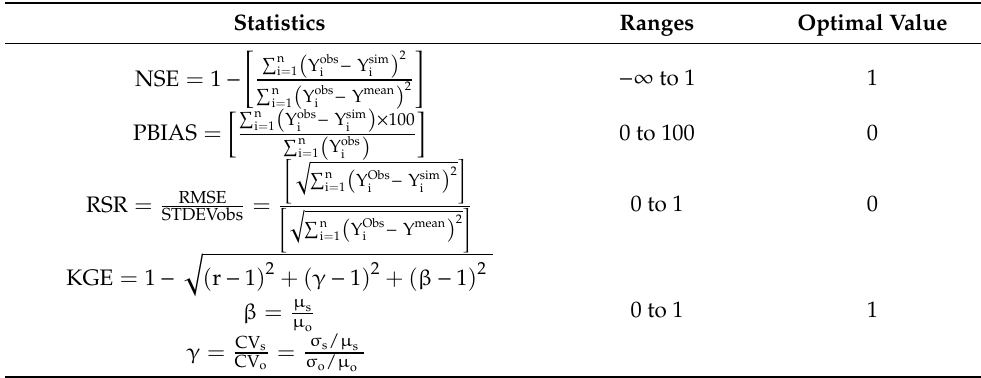
Table 1. Representing statistical model performance criteria. Statistics